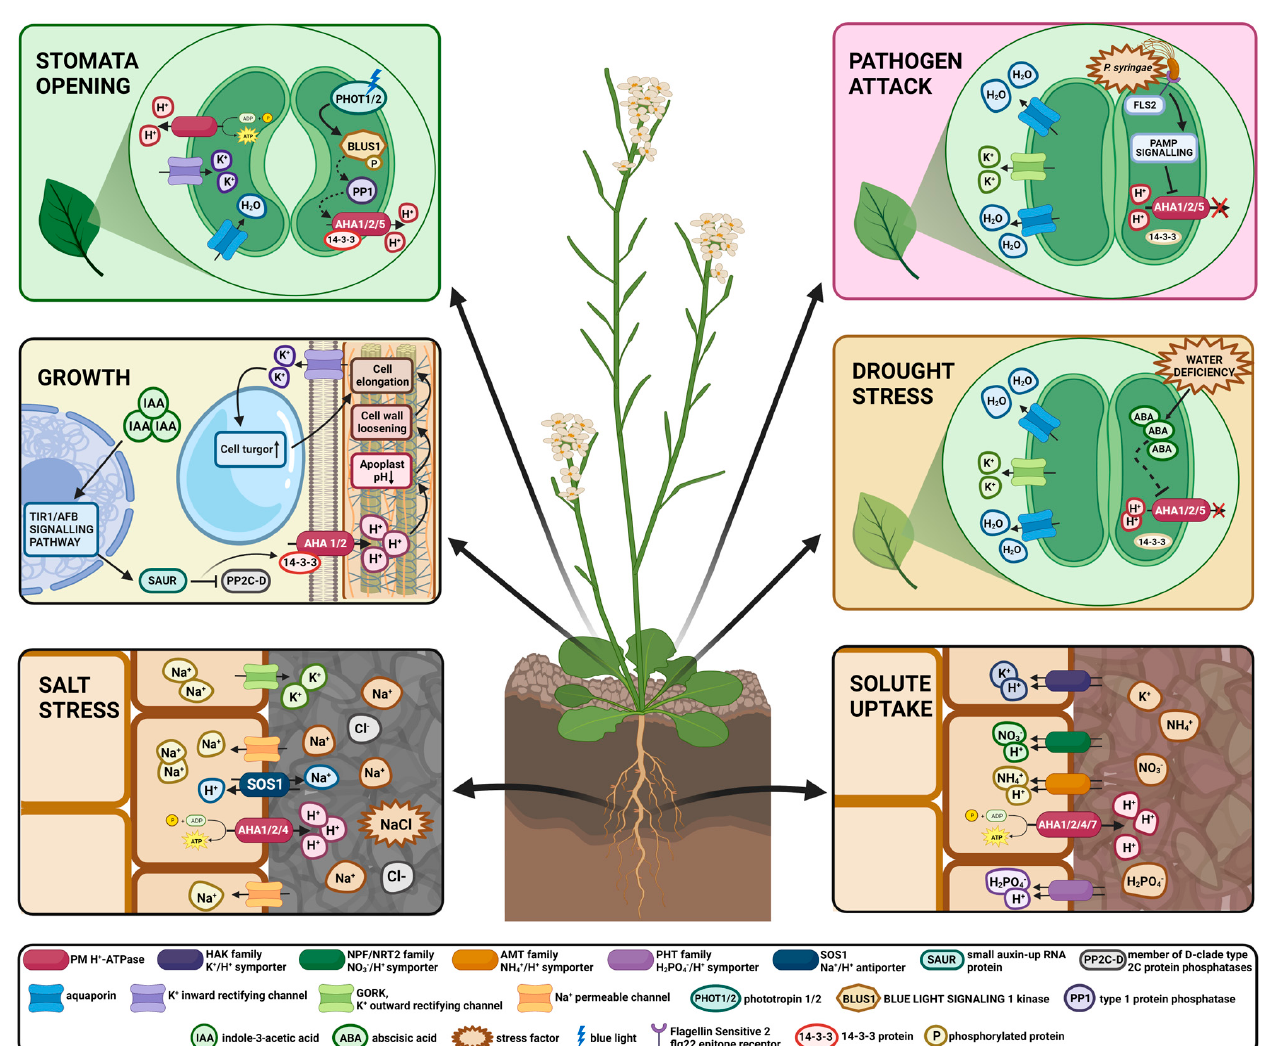
Figure 2. Summary of PM H + -ATPase multitasking in physiological processes in Arabidopsis thaliana . The figure was created with BioRender.com (Available at https://biorender.com, accessed on 12 December, 2022).